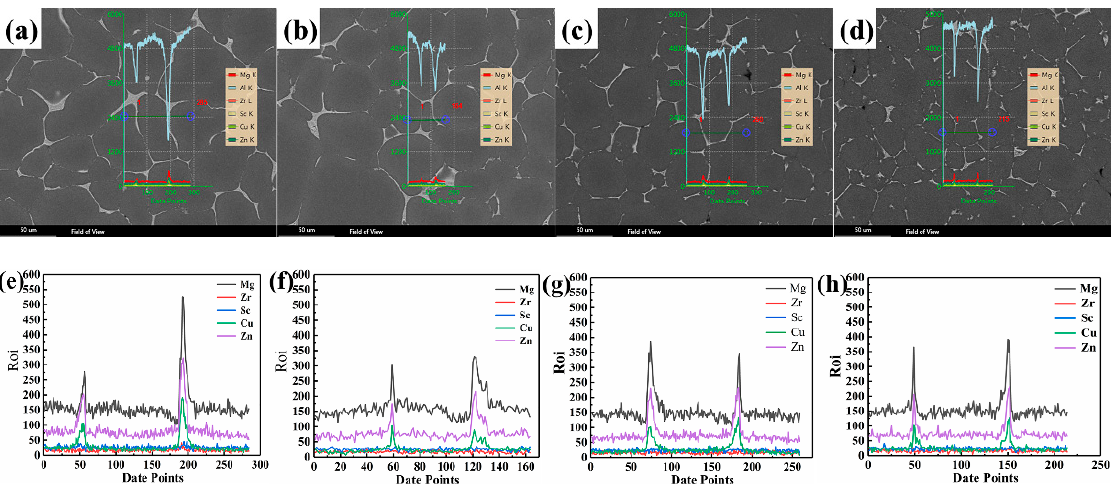
Figure 7. Line scanning element distribution among grains at different positions of squeeze castings under different conditions: ( a , e ) Without ESMT, edge; ( b , f ) Without ESMT, center; ( c , g ) With ESMT, edge; ( d , h ) With ESMT, center.